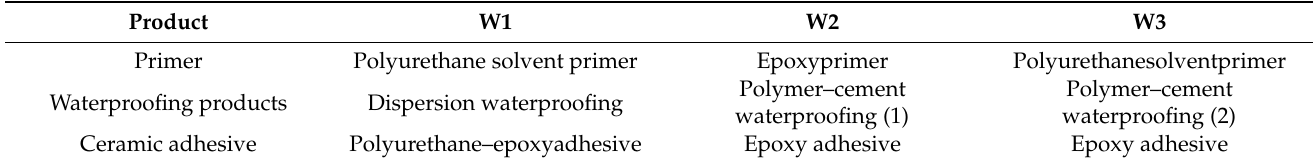
Table 3. Sets of multilayer construction products—W type (top layer is a ceramic tile).